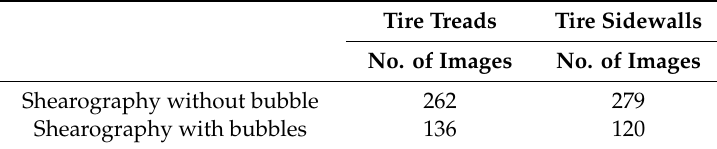
Table 3. Testing Dataset